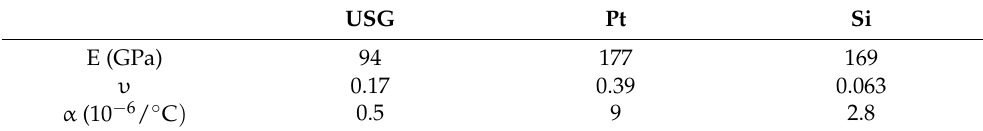
Figure 3. The whole thermal cycle used by Yao et al. [3]. Table 1. Materials ’ properties. Table 1. Materials’ properties.